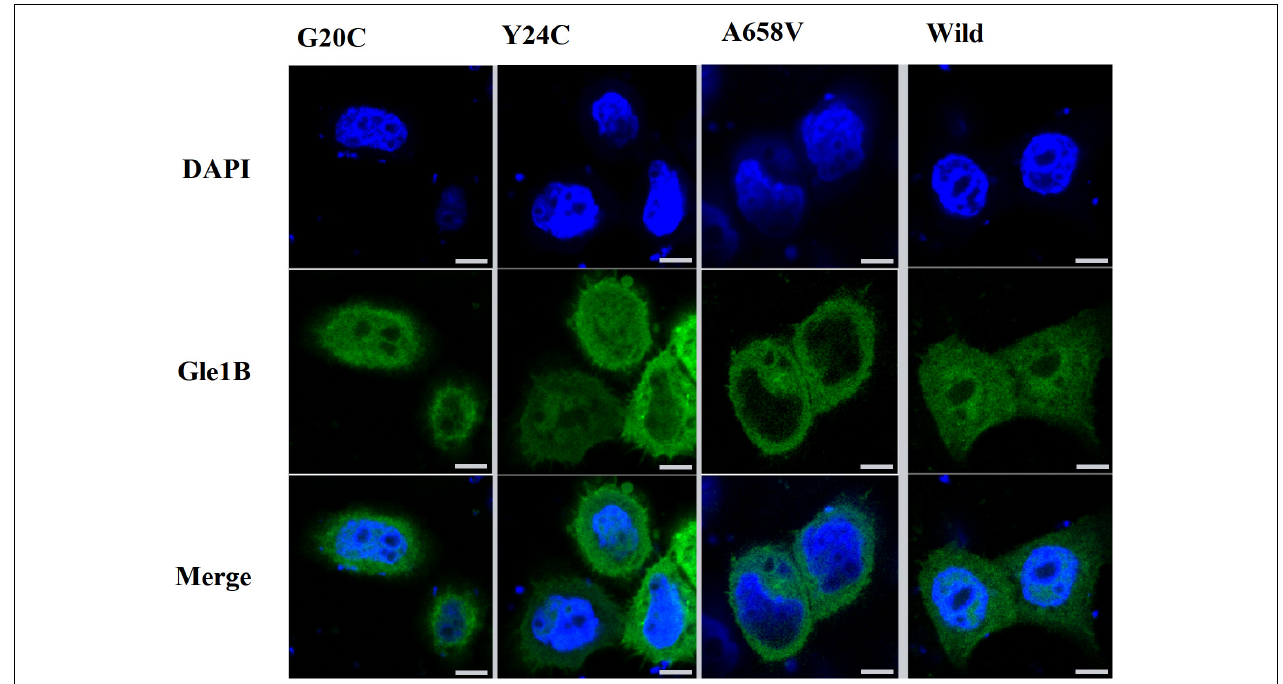
FIGURE 3 | The imaging of HeLa cells transfected with wild-type or mutant EGFP-tagged GLE1 constructs; scale bar: 10 µ m.